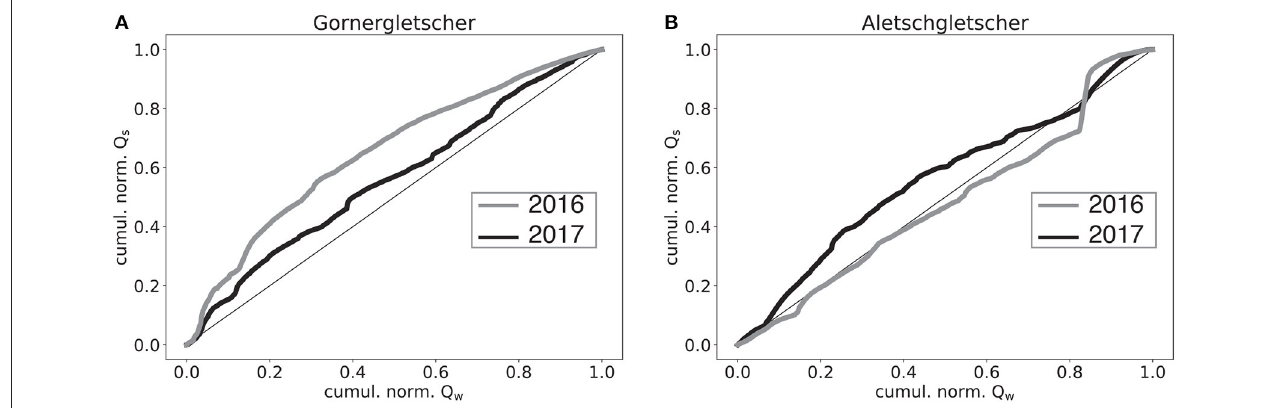
FIGURE 9 | Normalized cumulative amounts of sediment and water for 2016 (gray) and 2017 (black) for Gornergletscher (A) and Aletschgletscher (B) . Straight line represents constant relationship between water (Q w ) and sediment (Q s ) discharge.